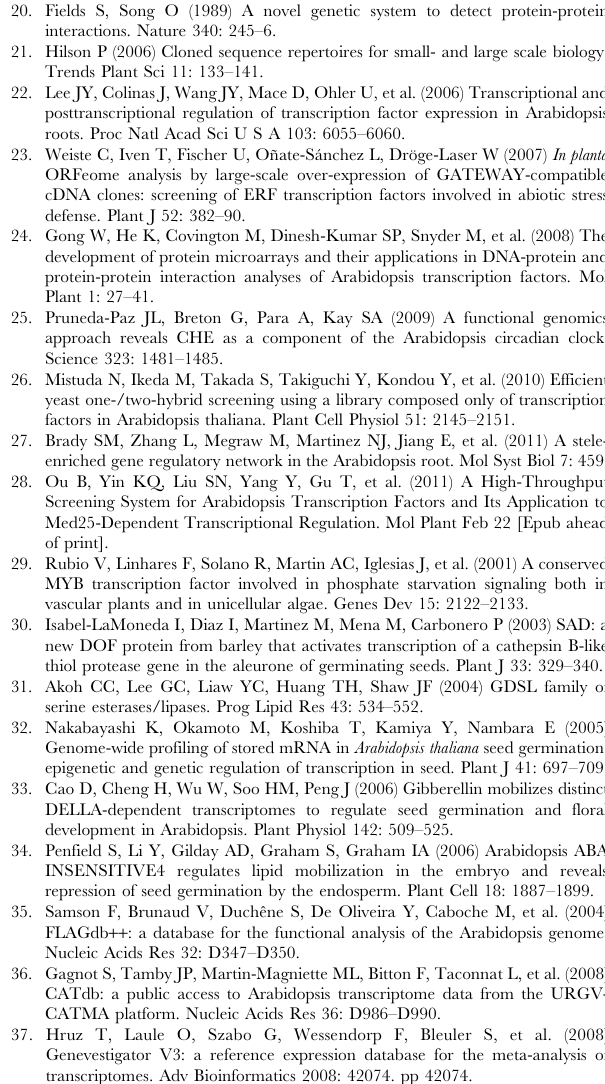
Table S1 List of TF ORFs in the REGULATORS collection. (XLS) Table S2 List of oligonucleotides used in the paper. (XLS) Table S3 Full coding sequences corresponding to ORFs that differ with their annotated sequences in databases. (DOC) Table S4 Sequencing results of randomly picked RR library clones.